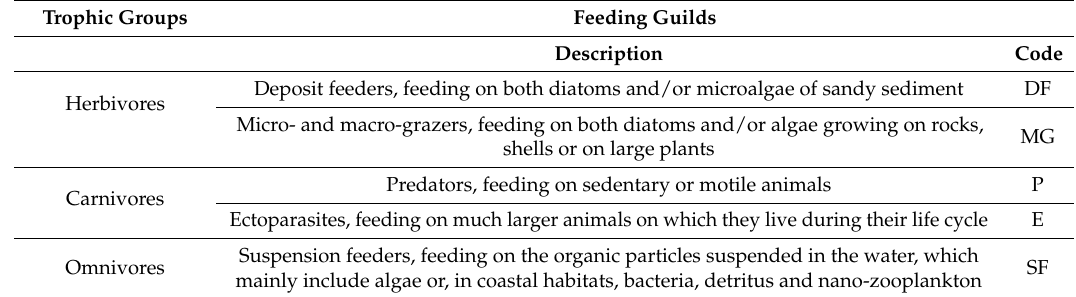
Table 1. List of trophic groups and description of relative feeding guilds with codes used in the species